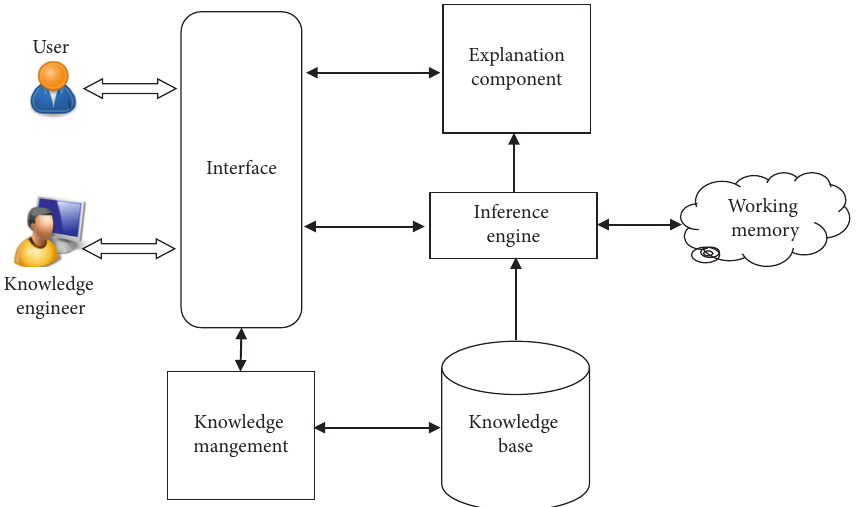
Figure 2: The architecture of an IPS in education [5,